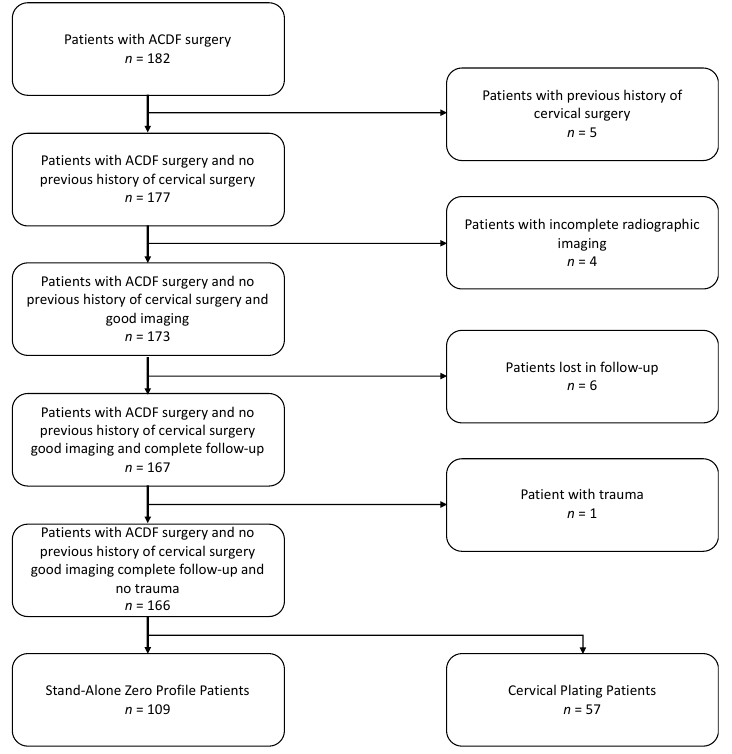
Figure 2. Flow Chart of Patient Cohort. ACDF = Anterior Cervical Discectomy and Fusion.